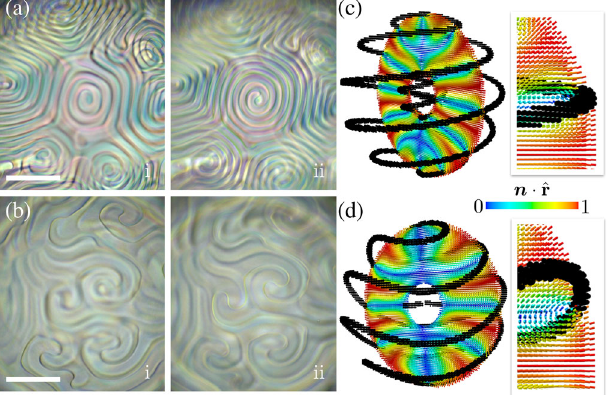
FIG. 10. Subsurface defect lines with strong homeotropic anchoring. CLC shells with 0.1 M NaCl in the water phases and 10 mM SDS in both the inner and outer phases (a) and only in the outer phase (b) have subsurface defect lines. Pictures are focused either on the inner surface (i) or on the outer surface (ii). Scale bars are all 50 μ m. (a,c) Because the defect lines (black lines in the simulations) form from both surfaces, the defect lines align to reduce the distortion. (b,d) Because the pitch axis must distort away from being parallel to the surface with hybrid anchoring, double spirals delineated by the defect line are less tightly wound. In the simulations in (c) and (d), the one-constant elastic constant approximation is used. The shells have a radius of 0 . 42 μ m and a thickness of 0 . 31 μ m. In this case, the smallness of the simulated shell is necessitated by the presence of the defect lines at the surface, which have a size governed by the nematic correlation length, on the order of a few nanometers [39]. The anchoring is strong, with W 0 ≈ 4 × 10 − 3 J = m 2 for the homeo- tropic surfaces and W 1 ≈ 4 × 10 − 3 J = m 2 for the planar ones. The pitch is 0 . 3 μ m. The coloring indicates the magnitude of the director along the radial ˆ r direction, perpendicular to the shell surfaces. The simulation insets show that the stripes in the hybrid anchoring case (d) are less tightly